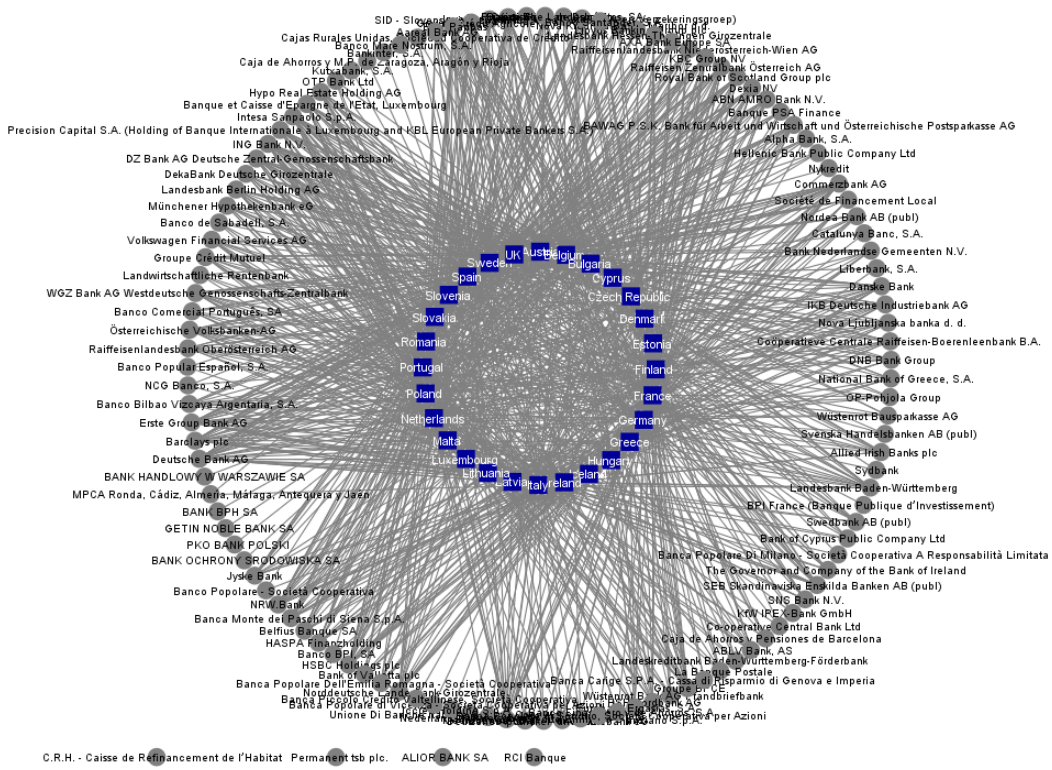
Figure 2. The Bank-sovereign Network as of December 2013 with Unweighted